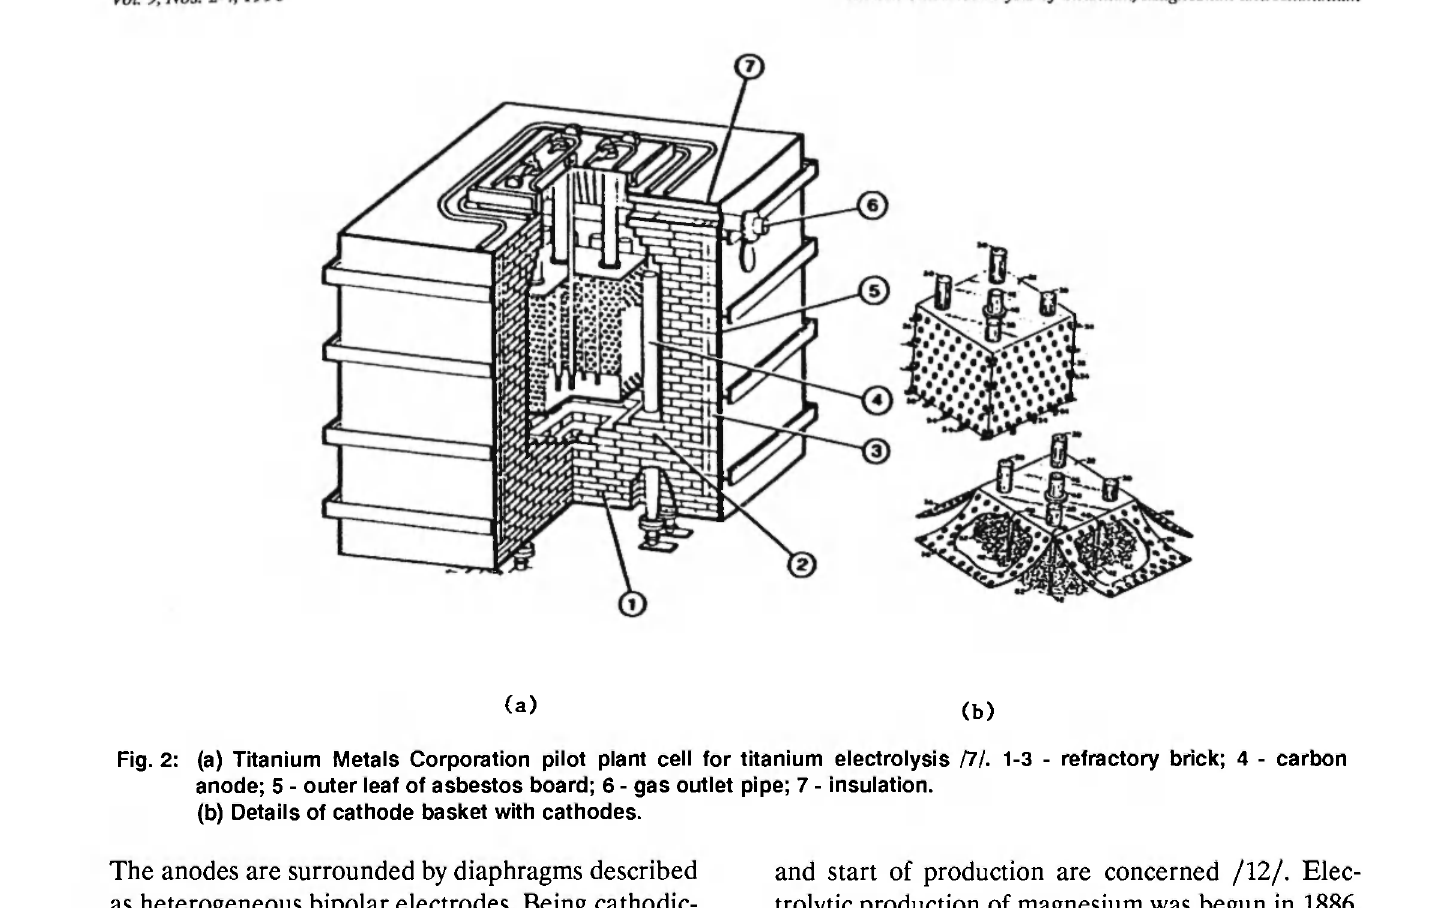
Fig. 2: (a) Titanium Metals Corporation pilot plant cell for titanium electrolysis 171. 1-3 - refractory brick; 4 - carbon anode; 5 - outer leaf of asbestos board; 6 - gas outlet pipe; 7 - insulation, (b) Details of cathode basket with